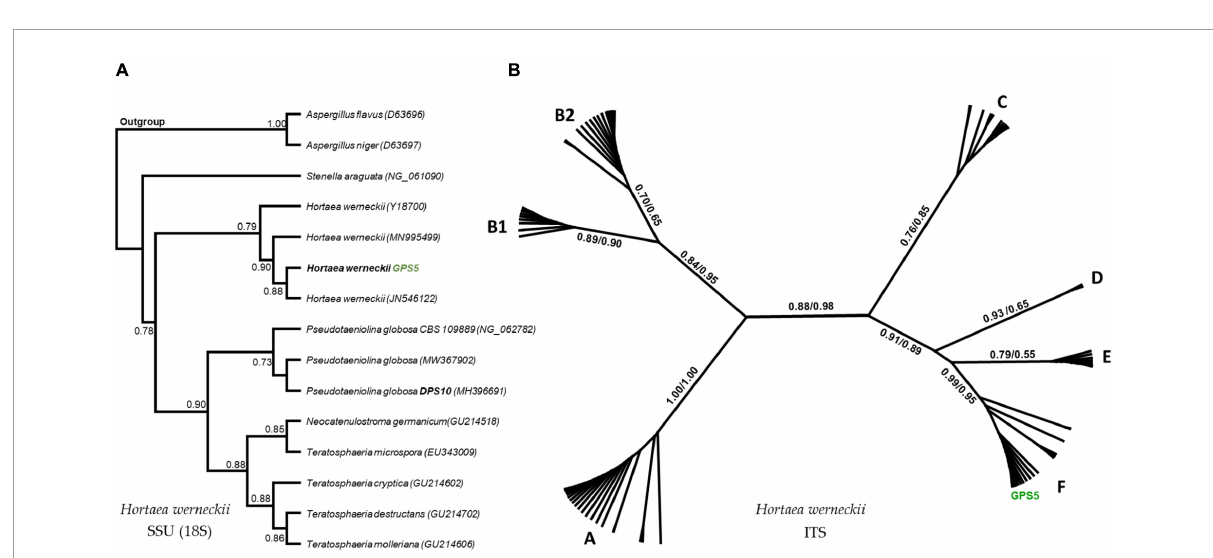
FIGURE6 Maximum-likelihood phylogenetic trees based on SSU and ITS regions. The rooted SSU tree shows the GPS5 isolate within the H. werneckii clade (A) . The ITS tree includes all data recorded for H. werneckii in the NCBI database, where different clusters were named by letters, while ML/BI bootstrap supports are written in numbers near each node (B)